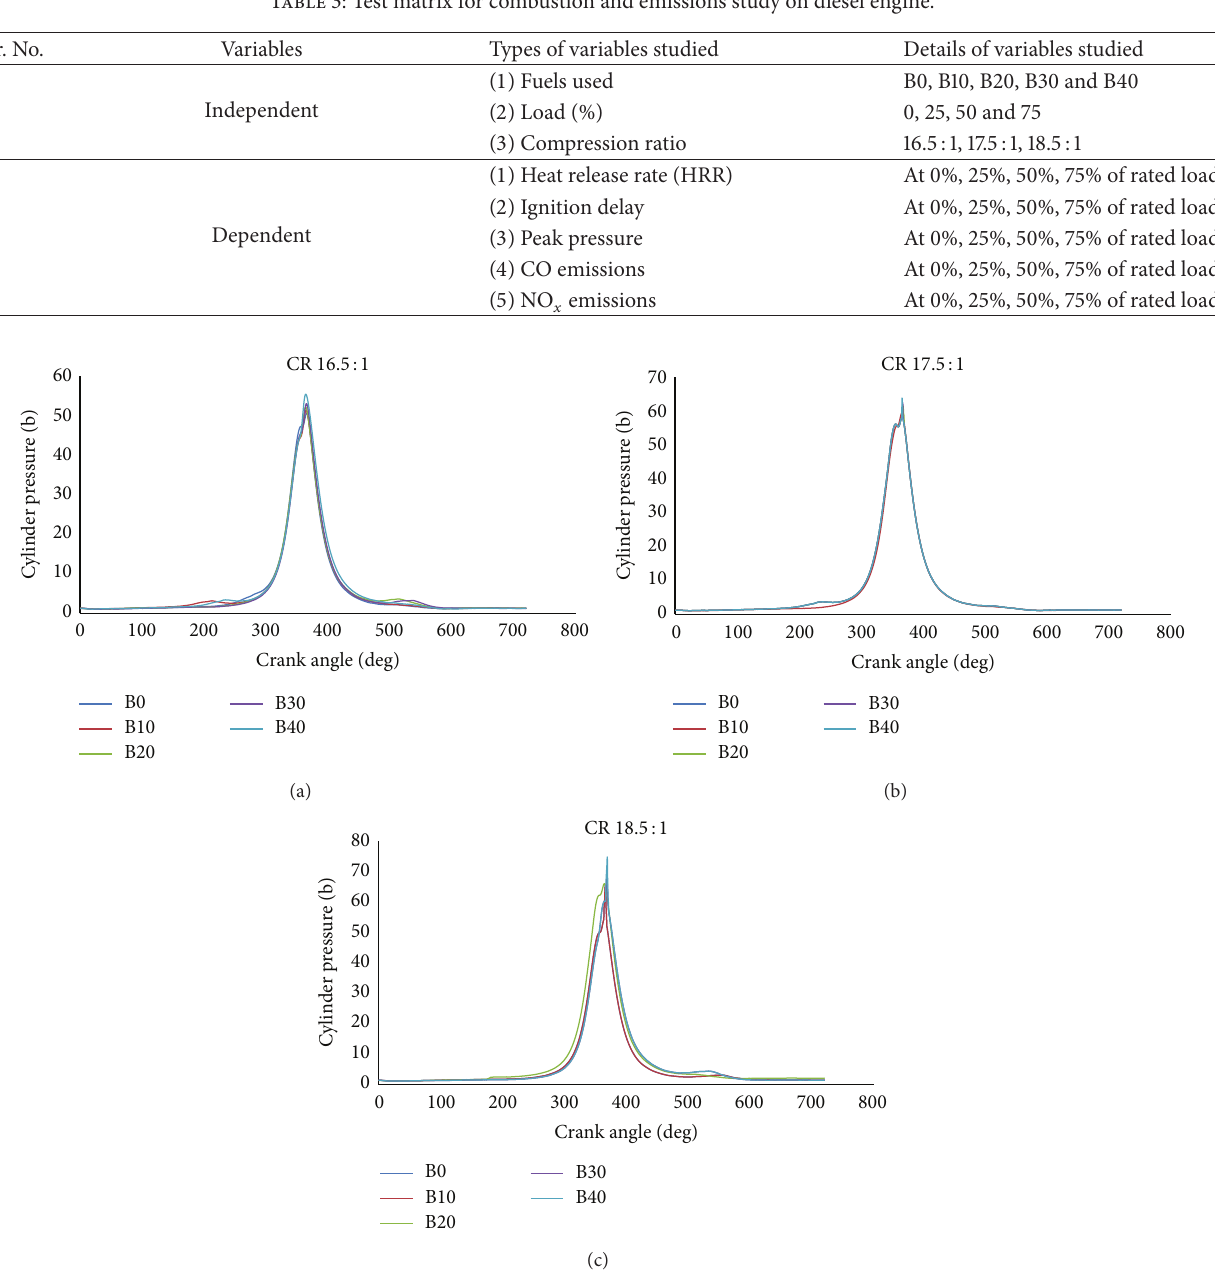
Figure 2: Pressure versus crank angle for all fuels at 75% of rated load for various compression